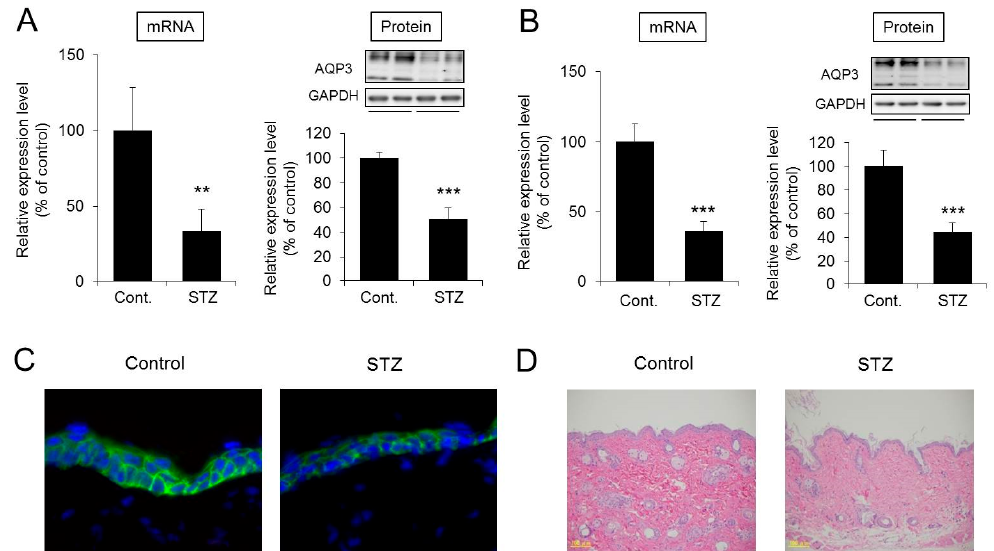
Figure 3. Expression levels and distribution of AQP3 in the skin. Mice were given a single intravenous administration of STZ. After four weeks ( A ) or eight weeks ( B ), the Aqp3 mRNA expression level in the skin was measured by real ‐ time RT ‐ PCR. After normalization to 18S rRNA , the data are presented with the mean value of the control group set at 100%. The protein expression of AQP3 in the skin was analyzed by Western blotting. After normalization to glyceraldehyde ‐ 3 ‐ phosphate dehydrogenase (GAPDH), the data are shown with the mean value of the control group set at 100% (mean ± SD, n = 5; ** p < 0.01 and *** p < 0.001). At four weeks after STZ treatment, AQP3 (green) and nuclei (blue) in mouse skin were immunostained ( C ). Skin tissue was assessed by hematoxylin and eosin (HE) staining ( D